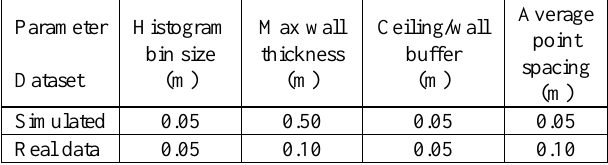
Table 1. Parameter settings used in the experiments.